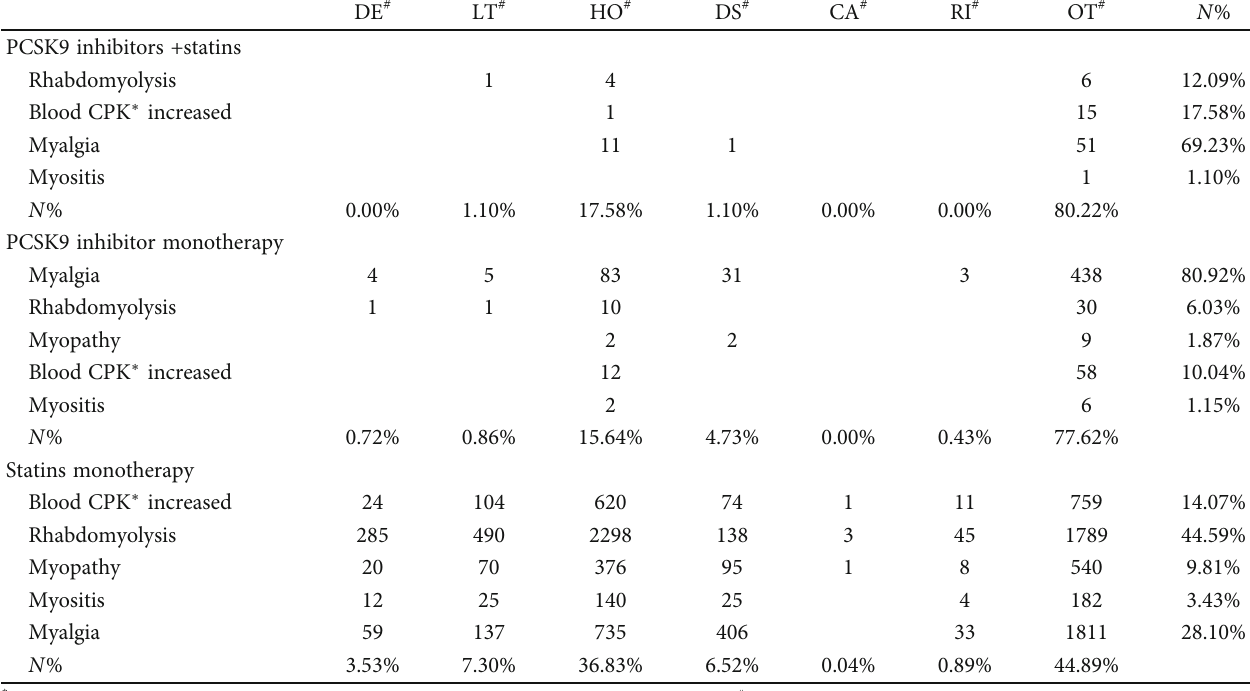
Table 3: Outcome distribution in terms of each PT $ for cases with MAEs $ because of PCSK9 inhibitors and